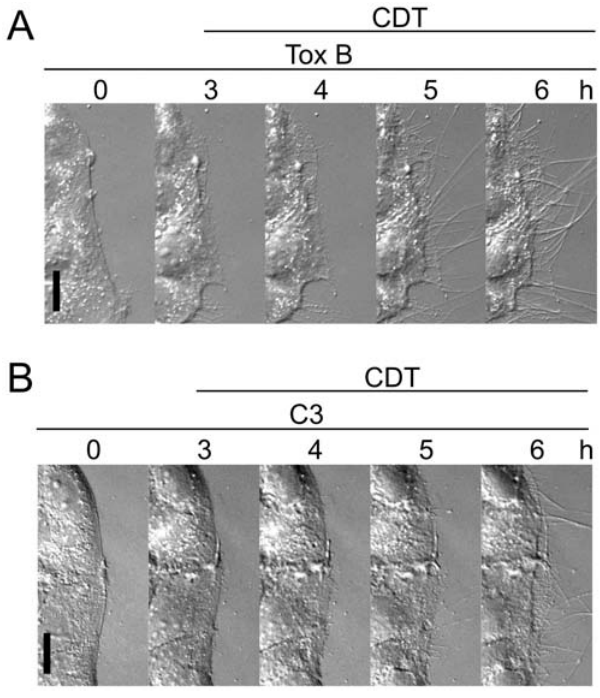
Figure 6. Influence of the Rho-inactivating toxin B and C3 toxin on CDT-induced protrusion formation. ( A ) Series of DIC time-lapse images of cells treated with 300 ng/ml toxin B at time point 0 h. After 3 h, 20 ng/ml CDTa and 40 ng/ml CDTb were added. Incubation was continued for 6 h. CDT induced the formation of microtubule-based protrusions after toxin B intoxication. Scale bar represents 20 m m. ( B ) Series of DIC time-lapse images of Caco-2 cells treated with 300 ng/ml C3 fusion toxin at time point 0 h. After 3 h, 20 ng/ml CDTa and 40 ng/ ml CDTb were added. The incubation was continued for 6 h. CDT induced the formation of microtubule-based protrusions after C3 intoxication. Scale bar represents 20 m m.